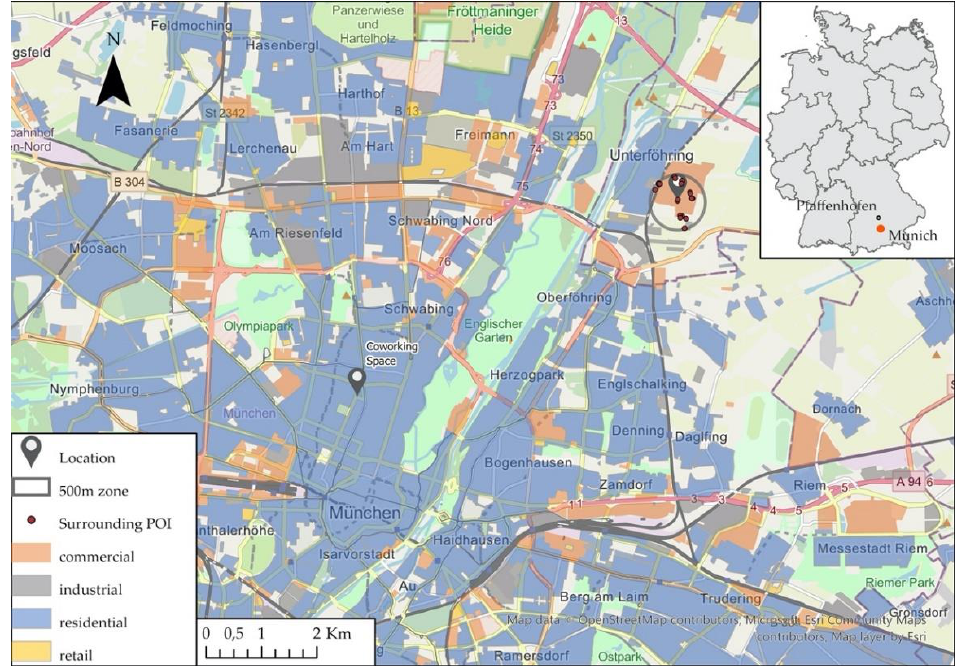
Figure 13. Map of all POIs in the category ’pois_free’ in Unterföhring, Munich (without scale). Source: ArcGIS ® software by Esri, OSM, gefabrik.de, coworkingmap.de, © GeoBasis-DE/BKG (2020).